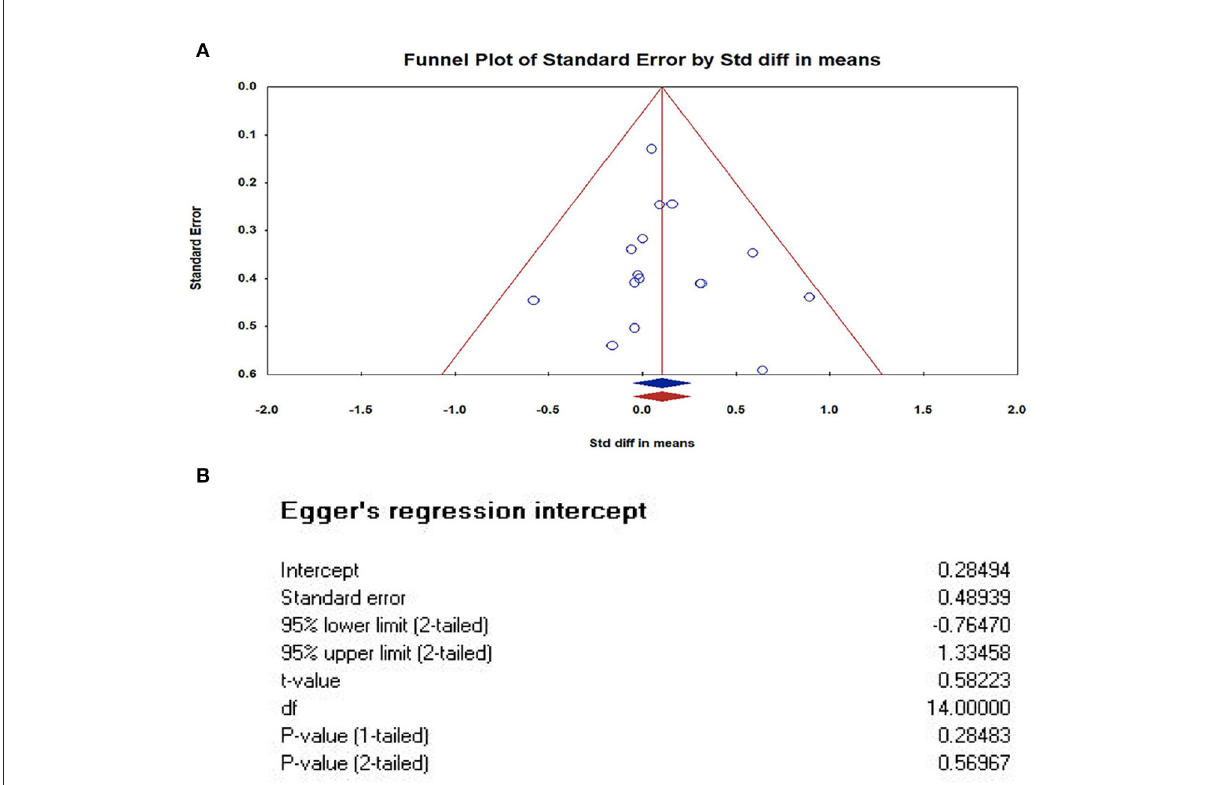
FIGURE4 Publication bias of studies. (A) Funnel Plot of Standard Error by Std diff in means (Plot observed and imputed); (B) The results of Egger’s tests. In this case the intercept (BO) is 0.28494, 95% confidence interval ( − 0.76470, 1.33458), with t = 0.58223, df = 14. The 1-tailed p -value (recommended) is 0.28483, and the 2-tailed p -value is 0.56967. The results of Egger’s tests indicates that there is no publication bias.